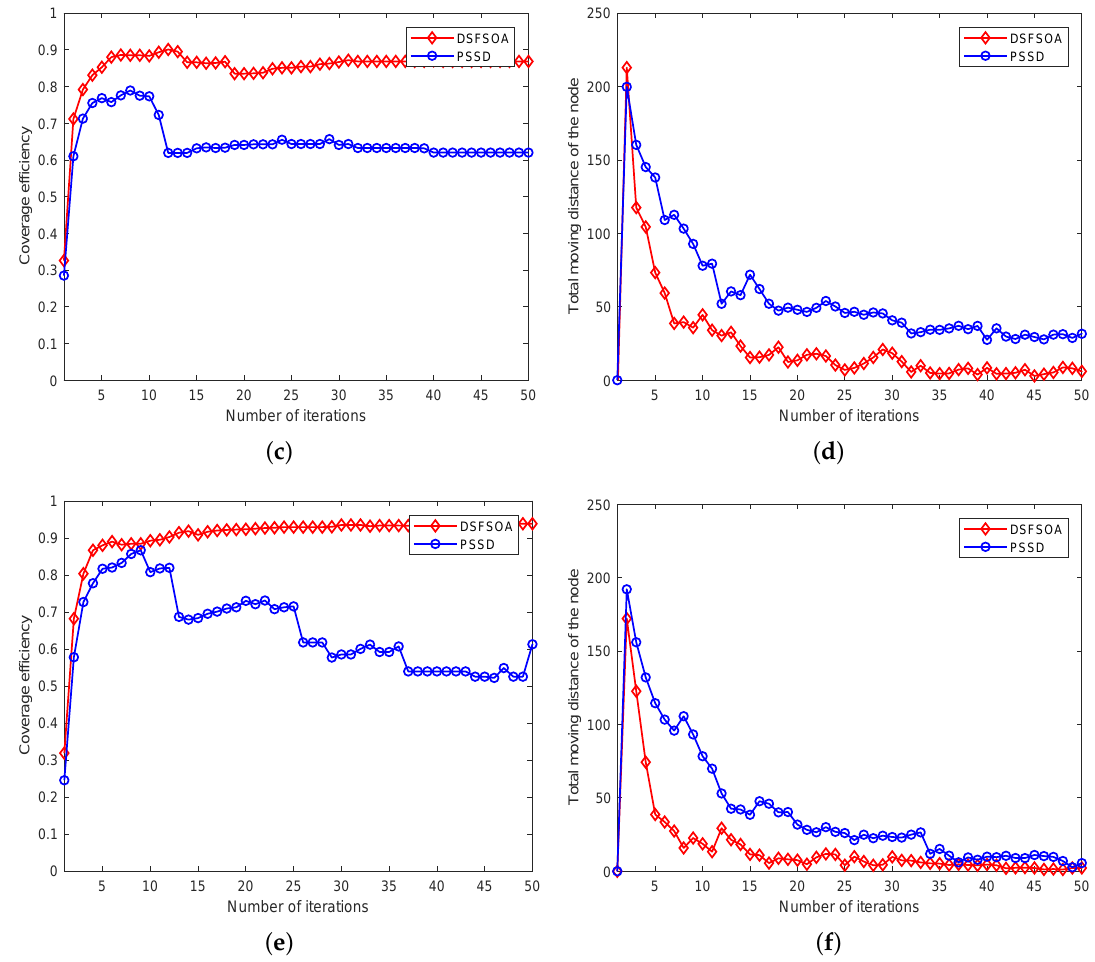
Figure 7. Comparison of the evolution of total moving distance and event coverage of two methods in three sets of experiments. ( a ) Experiment 1: average coverage; ( b ) Experiment 1: total moving distance of nodes; ( c ) Experiment 2: average coverage; ( d ) Experiment 2: total moving distance of nodes; ( e ) Experiment 3: average coverage; ( f ) Experiment 3: total moving distance of